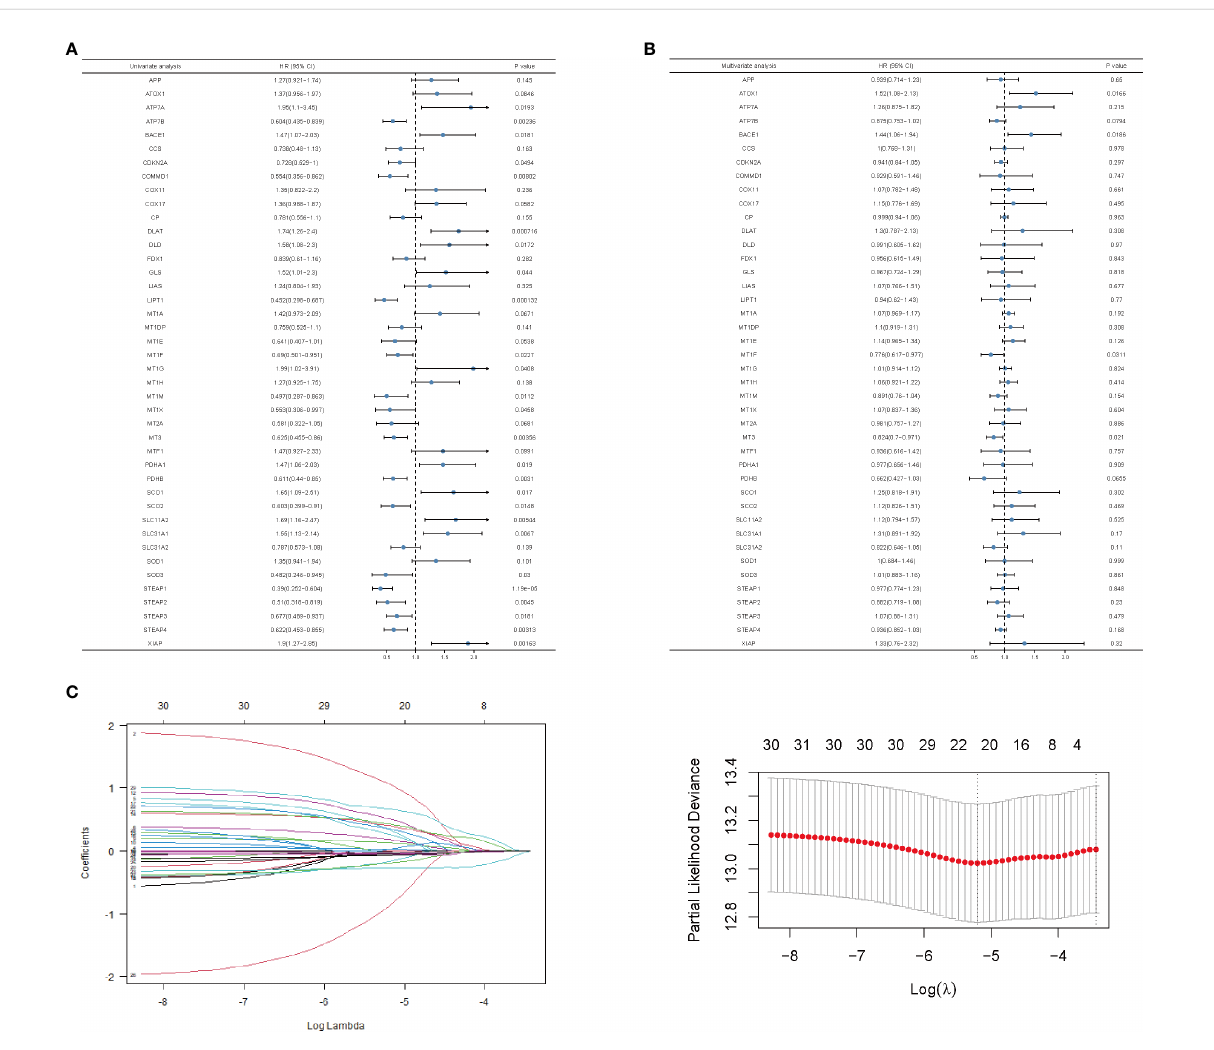
FIGURE 3 Univariate and multivariate analysis and LASSO-Cox regression of copper-related genes in breast cancer samples. Univariate (A) - and multivariate (B) -analysis of copper-related genes in breast cancer samples. (C) LASSO-Cox regression was built up from copper-related genes, based on which we selected optimal genes by the cross-validation